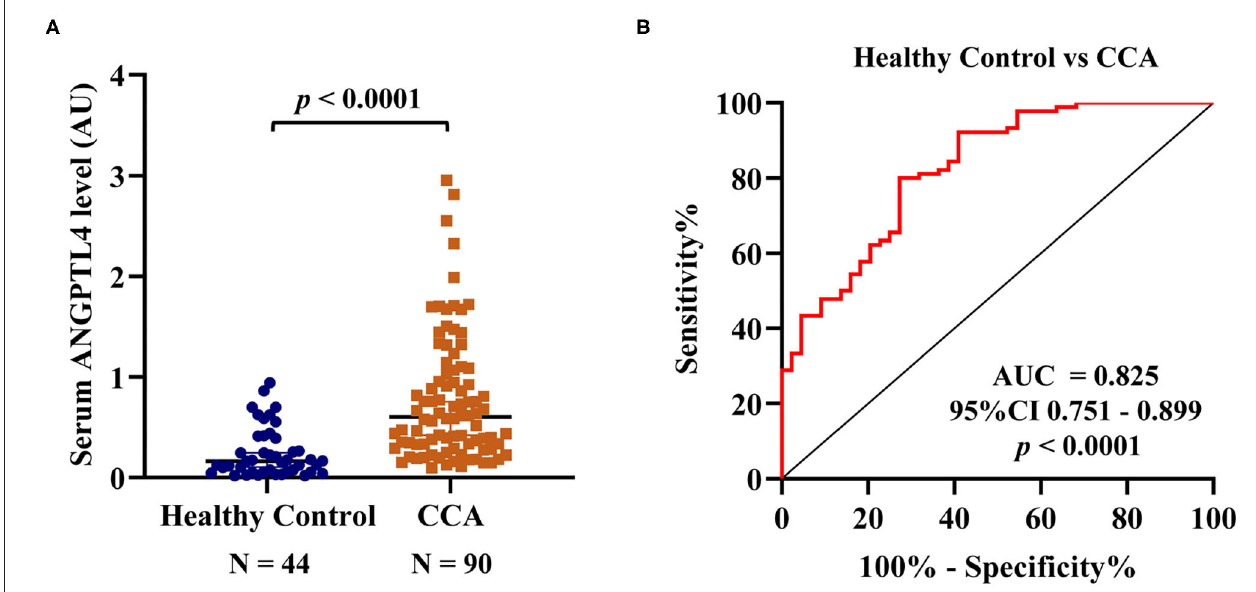
FIGURE 3 | (A) Serum ANGPTL4 level of HC and CCA patients by dot blot assay. The median ± quartile deviation, 0.1634 ± 0.1739AU (0.0193–0.9424AU), in healthy control and 0.6017 ± 0.3767AU (0.0984–2.9526AU) in CCA patients’ group. To normalize the expression level, the ratio of the intensity of each dot blot to that of the positive control (pooled CCA serum) was calculated and determined as the arbitrary unit (AU). The difference of serum ANGPTL4 level between HC and CCA by Mann-Whitney U-test. (B) ROC curve of serum ANGPTL4 level as a potential biomarker for prediction of CCA in comparison group of HC, sensitivity = 80.0% and specificity = 72.7% (AUC = 0.825, 95% CI 0.751–0.899, p < 0.0001). Statistical significance ( p < 0.05).